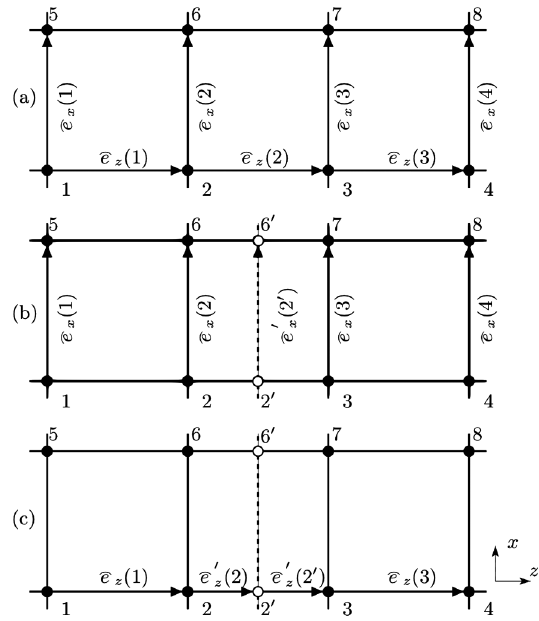
FIG. 4. The refinement of the dual grid (gray), imposed by the refined primary grid (thin black lines) is depicted. The initial situation is shown in (a). In order to preserve the duality of the ~6 ~2 two grids the dual nodes and have to be shifted. Their new ~6 0 ~2 0 and in (b) and (c). In addition, two position is indicated by ~6 00 ~2 00 and , have to be inserted. In (b) the assignment new nodes, of x -oriented magnetic voltages is shown and in (c) the assign- ment of z -oriented ð 2 Þ , oriented along the z z ð 2 Þ and ̑ e 0 ð 2 0 Þ z z ð 2 Þ and ̑ e 0 ð 2 0 Þ the voltage gradient, the refined voltages ̑ e 0 z z i.e., the average electric field, along the axis is approxi- mated by a central difference using the neighboring volt- ð 1 Þ and ̑ e ð 3 Þ . The voltages assigned to the refined ages ̑ e z z edges read